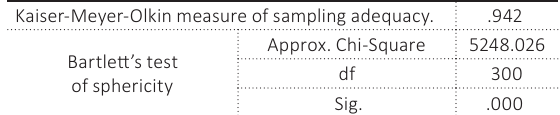
Table 3. KMO and Bartlett’s test Kaiser-Meyer-Olkin measure of sampling adequacy.